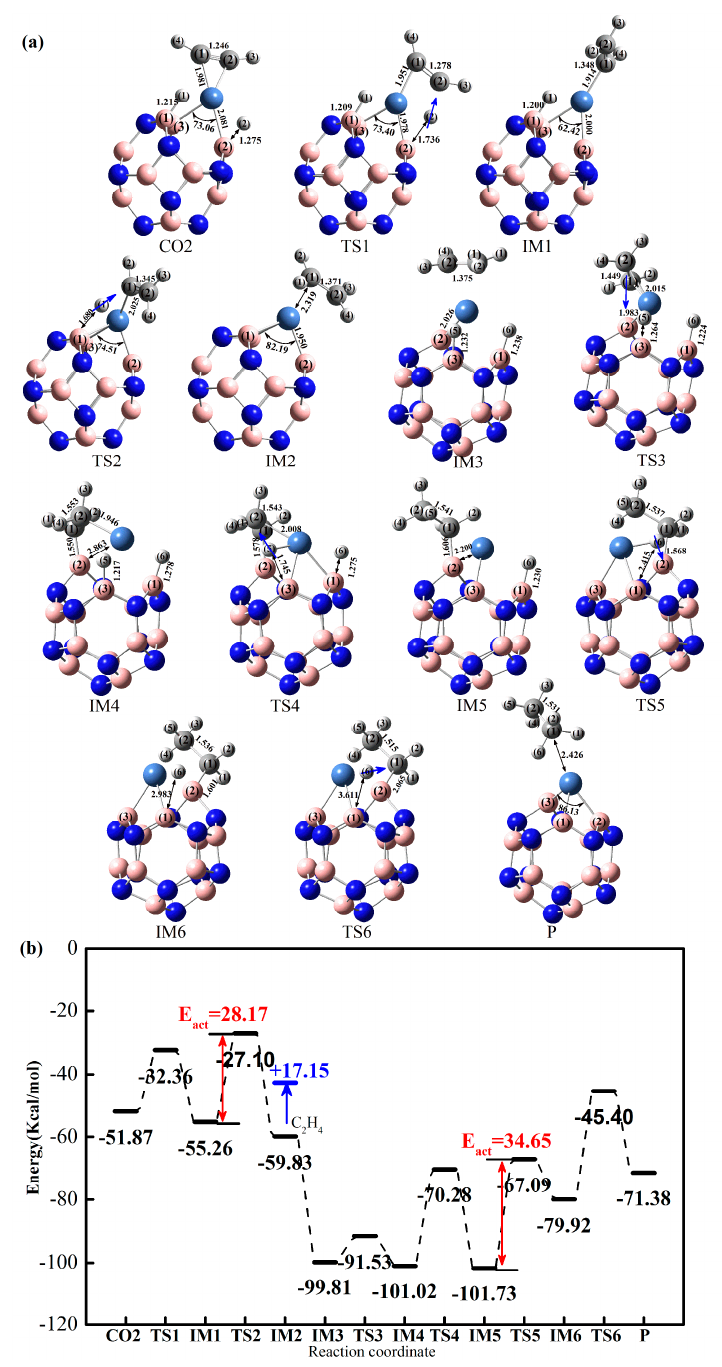
Figure 6. ( a ) The structures of calculated hydrogenation reaction diagram for the B 12 N 11 Ni. ( b ) The reaction process and potential energy change of catalytic hydrogenation of ethylene to ethane on the B 12 N 11 Ni. H atom is white; B atom is pink; C atom is grey; N atom is mazarine; Ni atom is blue.